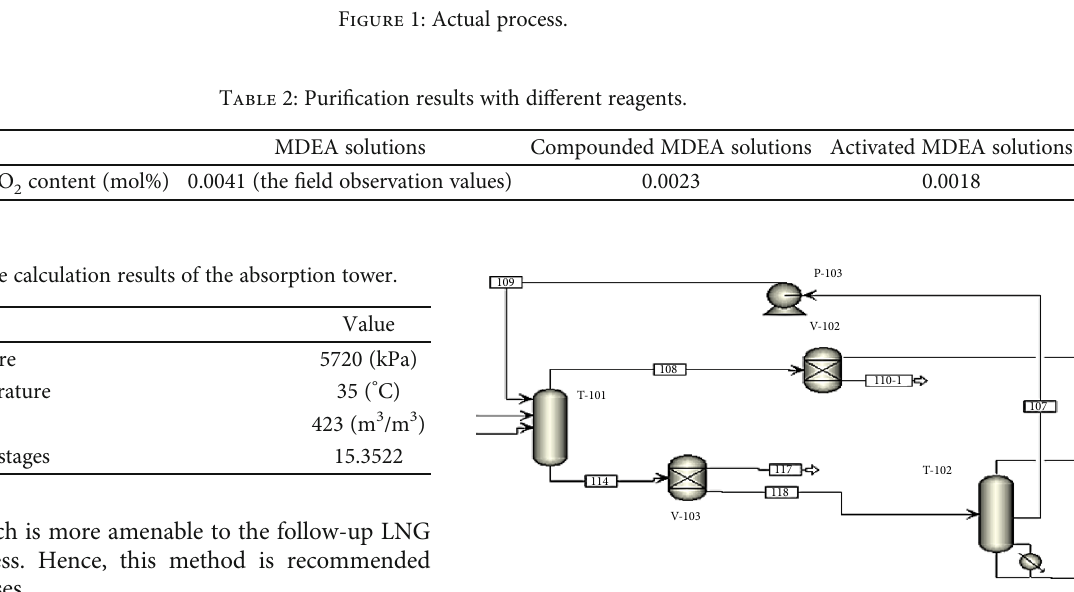
Figure 2: Schematic for the simulation of the semilean liquid process.